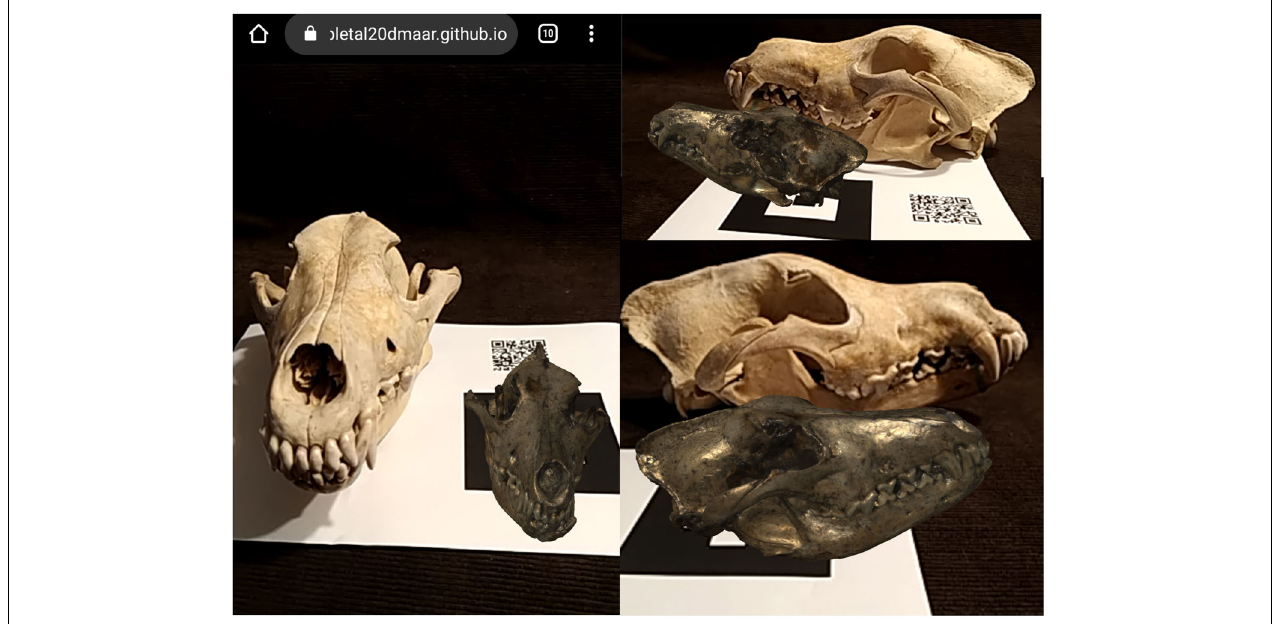
FIGURE 9 | Example of the visualization of the Augmented Reality web app in a comparison between a real cranium (that of an extant C. lupus ) and the digital model D64 of C. borjgali (as visible from Figure 6 ). The digital specimen is not at the same scale of the real specimen.